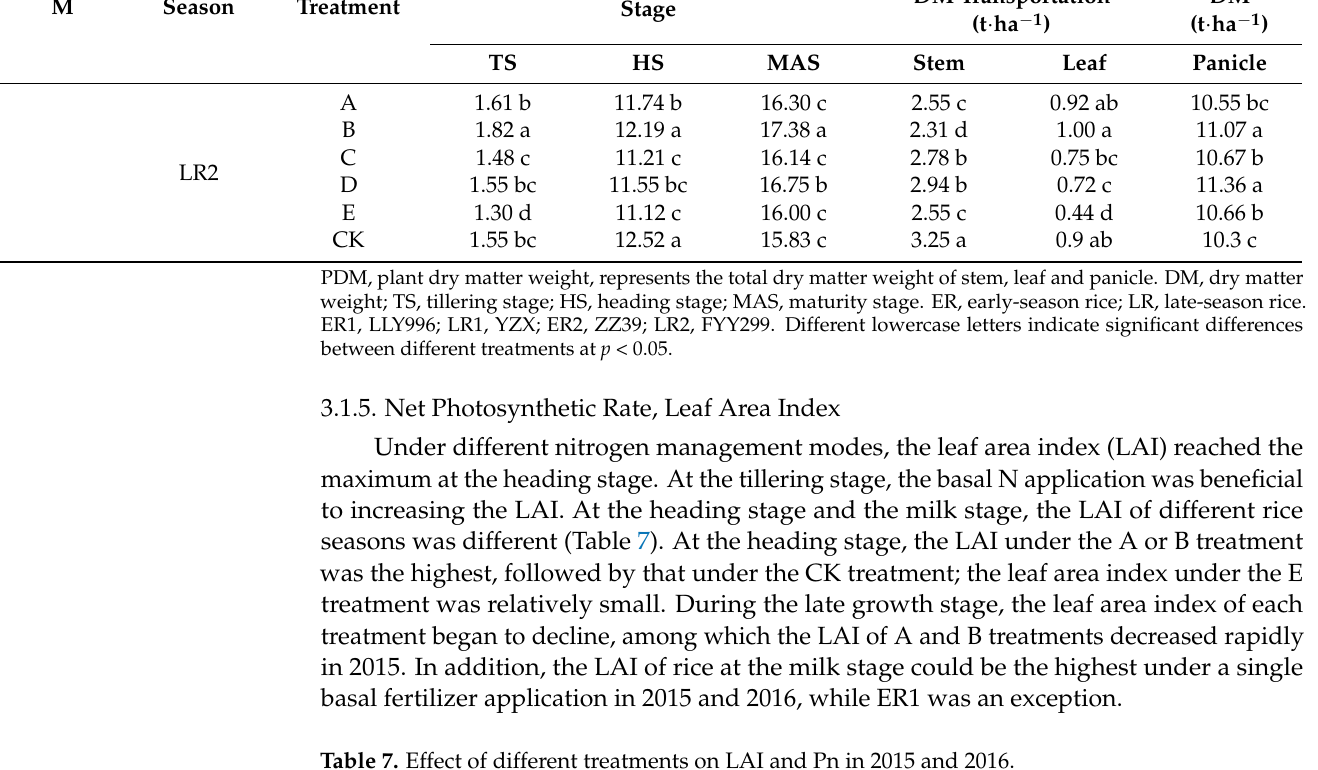
Table 7. Effect of different treatments on LAI and Pn in 2015 and